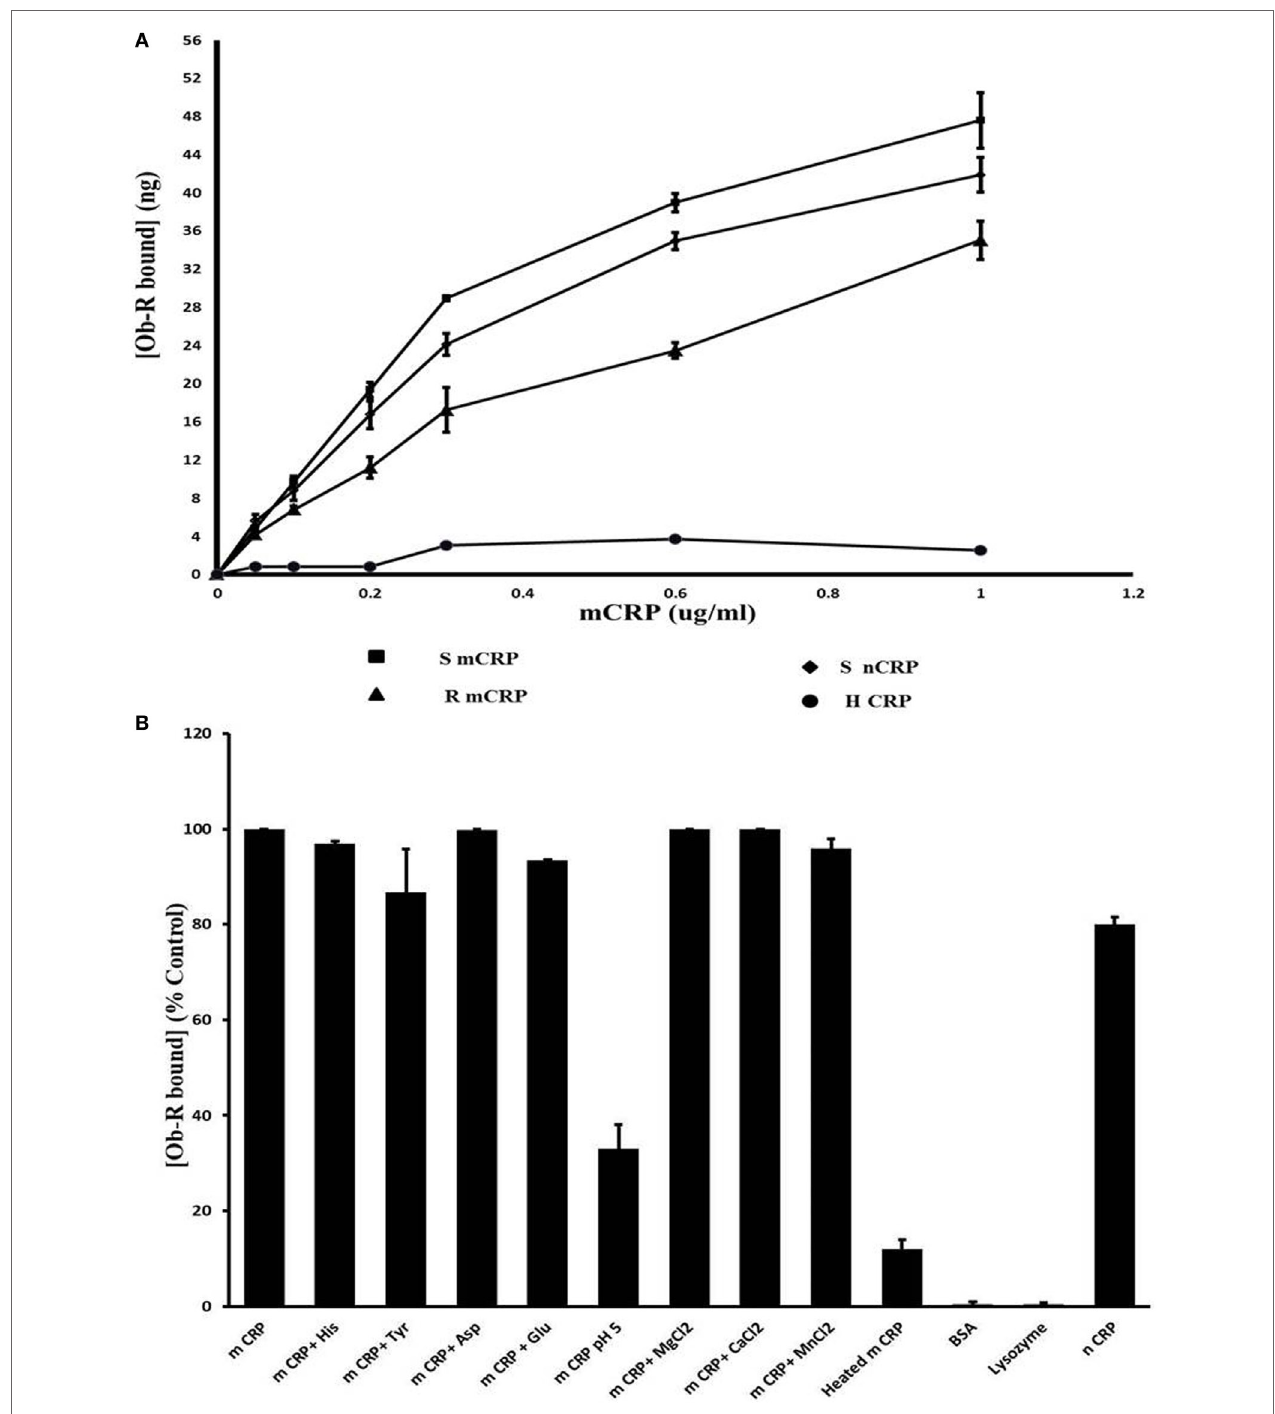
FigUre 5 | Solid phase binding assay of leptin receptor to C-reactive protein (CRP). (a) Concentration dependence: different concentrations of monomeric CRP (mCRP) from serum (s-mCRP), recombinant CRP (R-mCRP), native serum CRP (n-CRP), and heat treated (h-mCRP) were coated on to 96-well micro titer plate incubated with leptin receptor (100 ng of Ob R) and the amount of Ob R bound was quantitated by ELISA using anti-Ob R antibody and HRP-conjugated secondary antibody as described in text. Values given are the average of 3–6 experiments done in duplicate ± SD. (B) Effect of different substances: mCRP (0.6 µg/ml) was coated on to 96-well micro titer plate and binding of leptin receptor in the presence of different cations (1 µM each of MnCl 2 , MgCl 2 , and CaCl 2 ), or different amino acids (1 µM each of His, Tyr, Asp, and Glu) or in buffer pH 5.0 was assayed. Binding of leptin receptor to wells coated with BSA (100 µg/ml), lysozyme (100 µg/ml) native CRP (nCRP), or heat-treated CRP (0.6 µg/ml) was also analyzed. Results are expressed as percent of untreated mCRP control. Each value represents mean ± SD of three experiments.